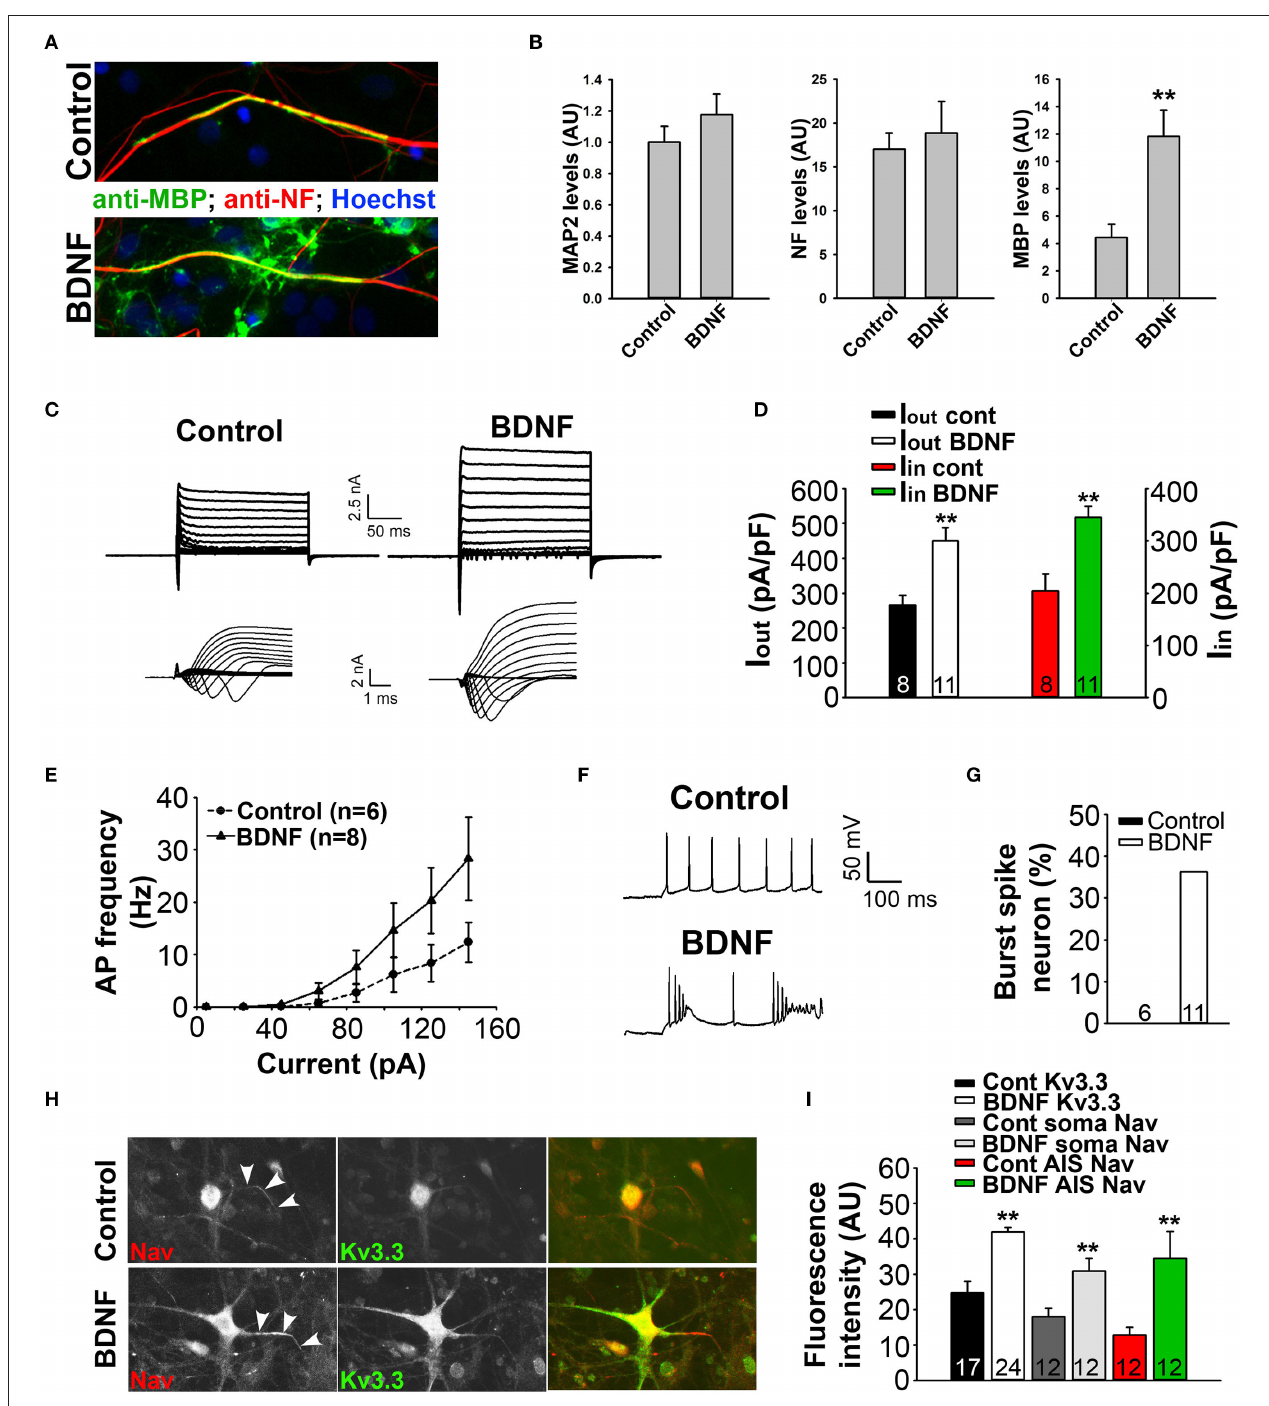
FIGURE 8 | BDNF treatment stimulates axon myelination and increases neuronal excitability. (A) BDNF treatment (bottom) increased axon myelination of cultured SC neurons. (B) Summary of BDNF treatment on the levels of MAP2, neurofilament (NF) and MBP. (C) BDNF treatment increased the levels of inward and outward currents under the voltage-clamp mode. (D) Summary of inward and outward current amplitudes. (E) BDNF treatment increased action potential firing frequency revealed by the input-output relationship. (F,G) BDNF treatment increased burst firing. (H) BDNF treatment (bottom) increased the endogenous expression levels of Kv3.3 (green) and Nav (red) channels. (I) Summary of the expression levels of endogenous Kv3.3 and Nav channels at the soma and AIS. Unpaired Student t –test: ** p < 0.01. Scale bars, 50 µ m.